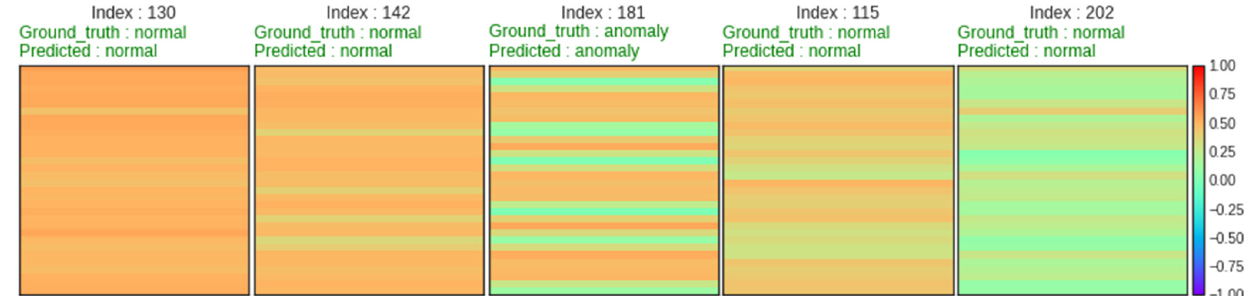
Figure 3. Slide rail data (8 K) DWT image encoding.